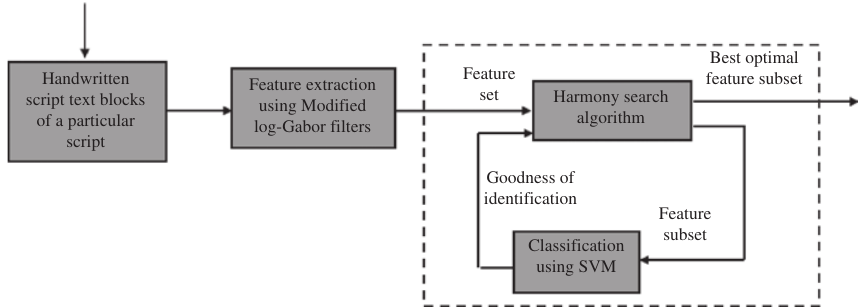
Figure 2: Schematic Diagram of the Proposed Two-Pass Approach for Handwritten Script Identification.